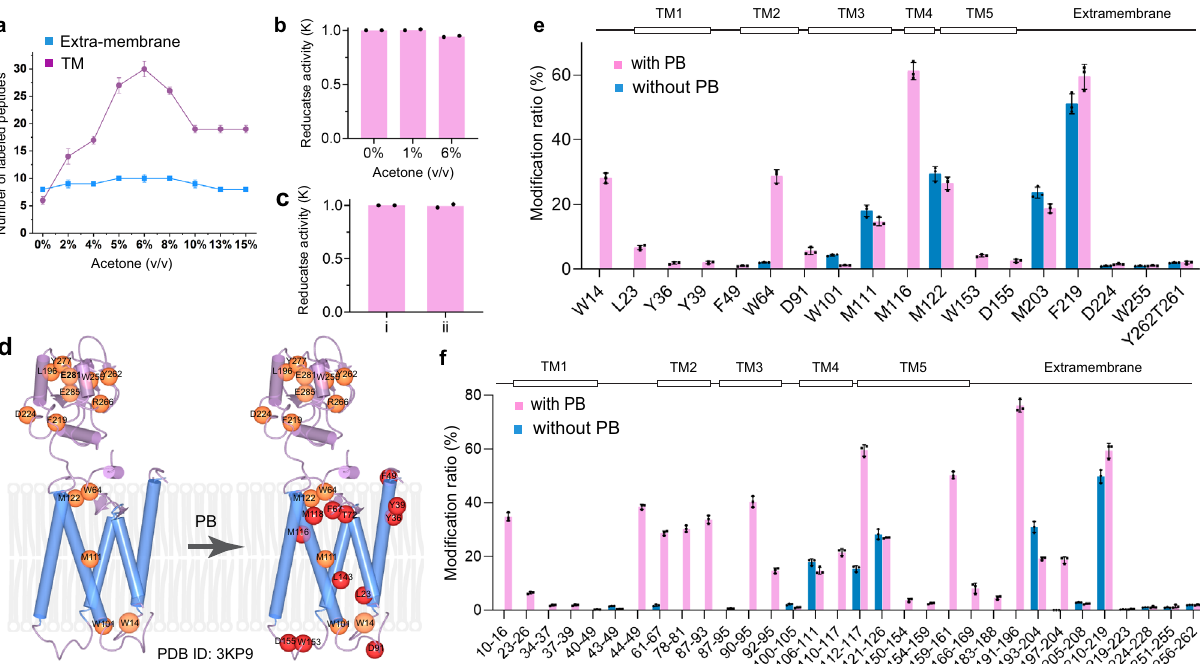
Fig. 2 NanoPOMP performance on VKOR. a The number of labeled peptides for the extra-membrane and TM regions of VKOR (PDB ID: 3KP9 40 ) as a function of the amount of acetone (blue-extra-membrane; purple-TM) ( n = 3 independent experiments per group, data are presented as mean values ± SD). b Enzyme activity of VKOR in liposome in presence of different amount of acetone ( n = 2 independent experiments per group, data are presented as mean values and dots represent the two corresponding individual repeats). c Enzyme activity of VKOR in liposome (i) without TiO 2 NPs, and (ii) with TiO 2 NPs. n = 2 independent experiments per group, data are presented as mean values and dots represent the two corresponding individual repeats. d Cartoon diagram showing sites labeled by NanoPOMP. Red circles represent modi fi ed sites in the TM with PB reaction, and orange circles represent those without PB. e Residue-level modi fi cation ratios upon irradiation of TiO 2 NPs with and without the PB reaction (purple-with PB; blue- without PB). n = 3 independent experiments per group, data are presented as mean values± SD and dots represent the corresponding individual repeats. f Modi fi cation ratios at peptide level (purple-with PB; blue-without PB). n = 3 independent experiments per group, data are presented as mean values ± SD and dots represent the corresponding individual repeats. Source data are provided as a Source Data fi